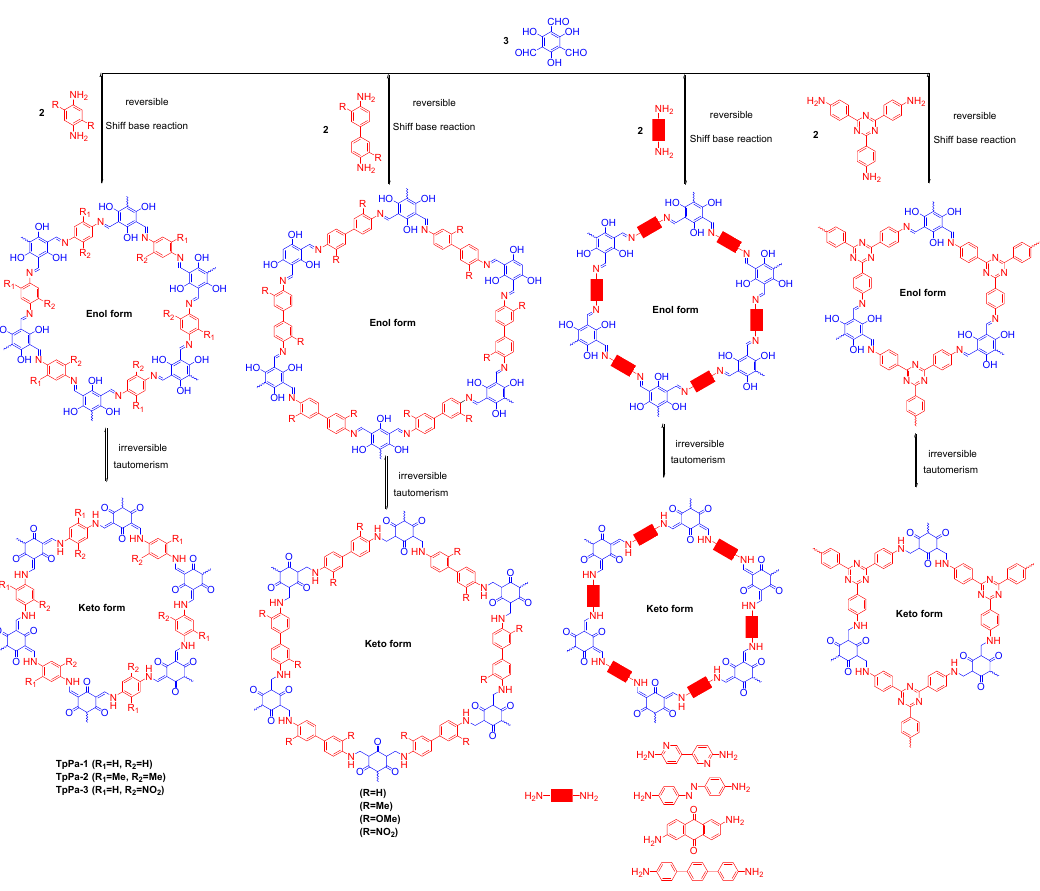
Figure 17. Construction of secondary amine-linked COFs via tautomerism by linking Tp with ditopic or tripic aniline-based linkers.